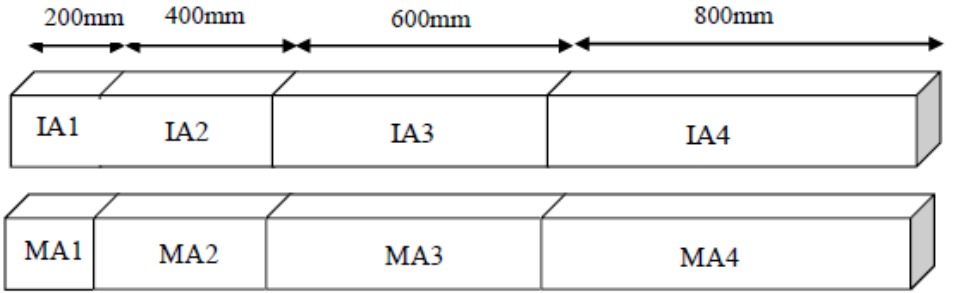
Fig. 1. Lengths of Timber